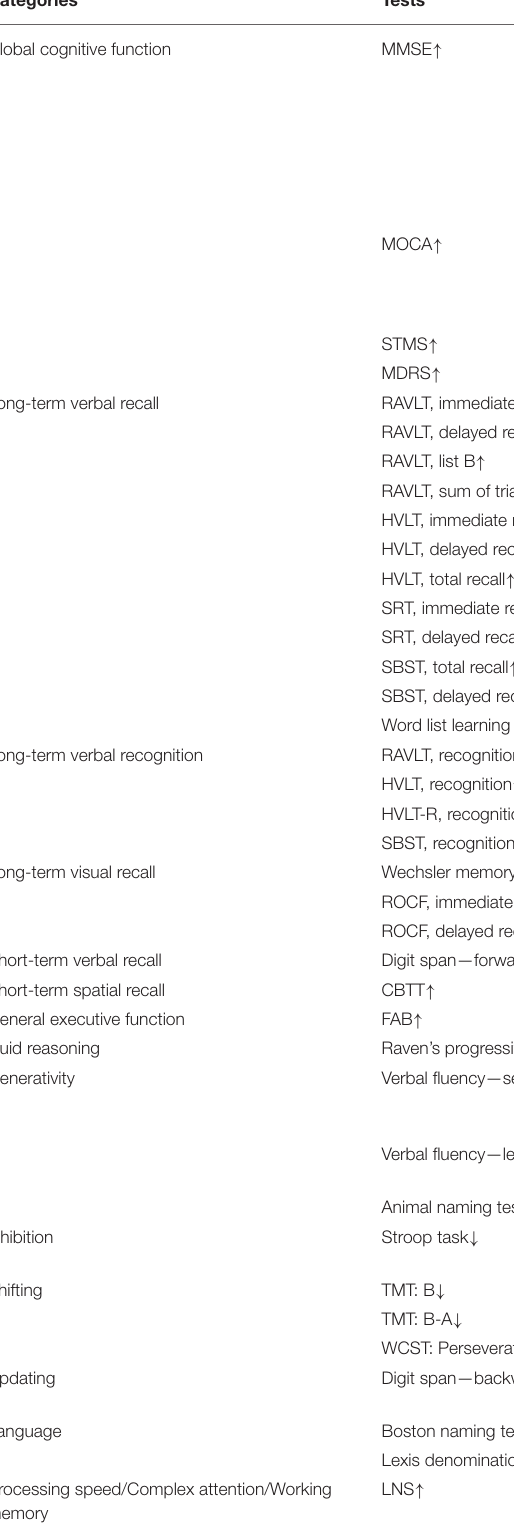
TABLE 1 | Cognitive domains and neuropsychological tests included in the primary studies.